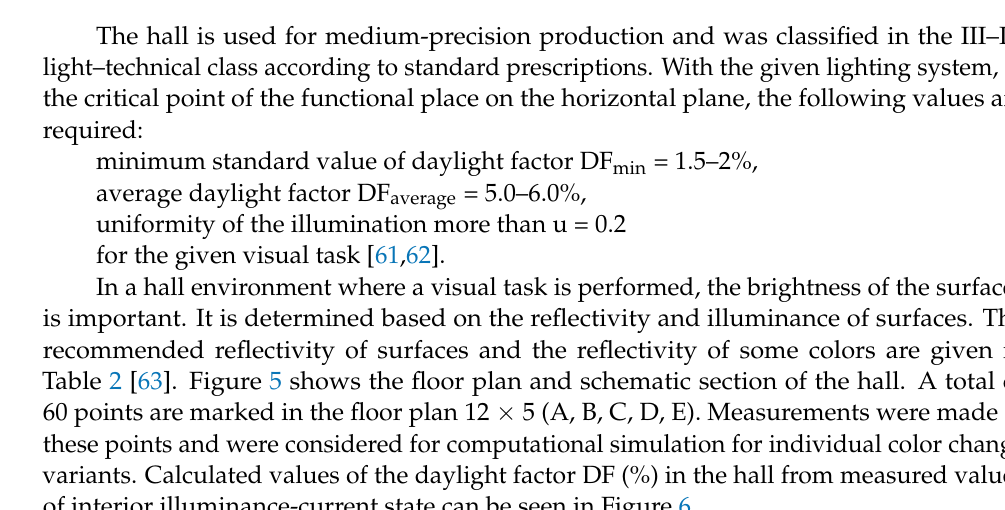
Figure 6. Calculated values of the daylight factor DF (%) in hall from measured values of interior illuminance-current state. Table 2. Recommended reflection factor of surfaces, recommended reflection factor of colors, build- ing material, and optical properties of the interior surfaces of the test hall. Reflectance/Trans- Structural Surface Color of Surface Reflectance Structural Surface mittance